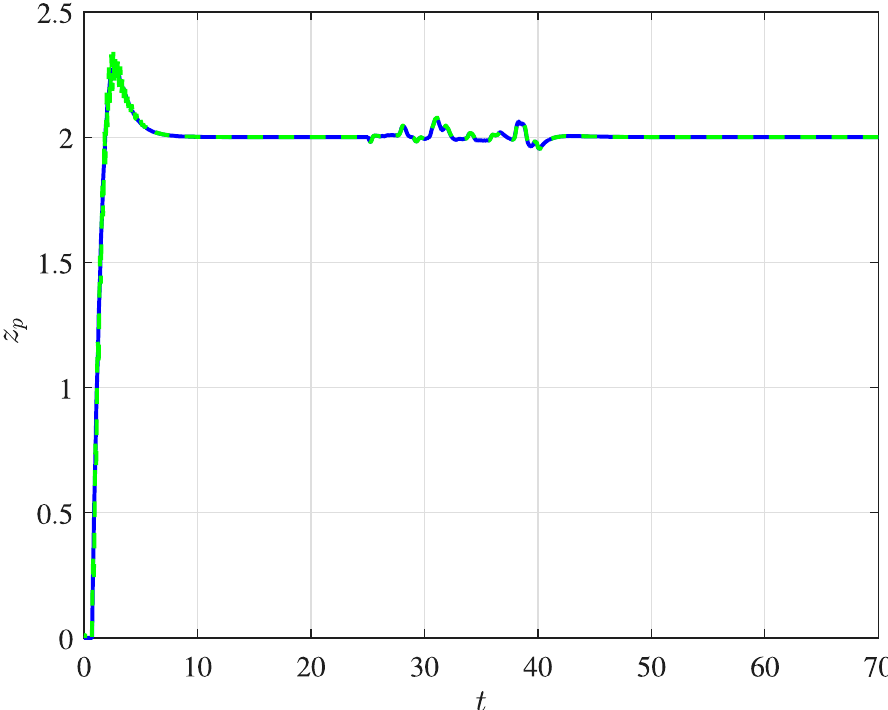
Figure 18. Vertical trajectory of the payload using the RDO technique, showing the current (solid blue line) and estimated (dashed green line) paths.